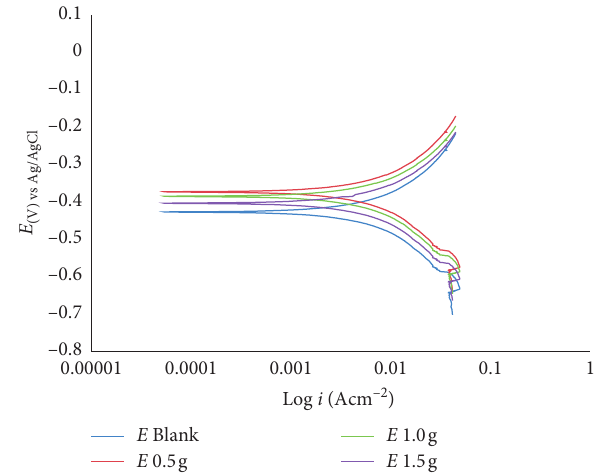
Figure 7: Potentiodynamic polarization curve of mild steel in dilute H 2 SO 4 in the absence and presence of the corrosion inhibitor at 60 ° C.